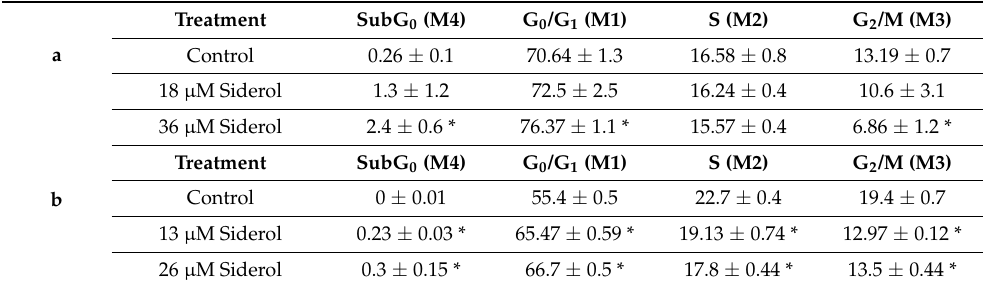
Figure 6. Graphical representation of cell-cycle distribution in both cell lines after treatment with siderol in IC50 and twice IC50 concentrations. An asterisk is used to indicate differences that were significant ( p < 0.05). Table 1. Cell-cycle distribution assessed by flow cytometry in T98 ( a ) and U87 ( b ) glioblastoma cells after treatment with siderol. The experiment was carried out three times and the values are means of three repetitions. Significant differences ( p < 0.05) are marked with an